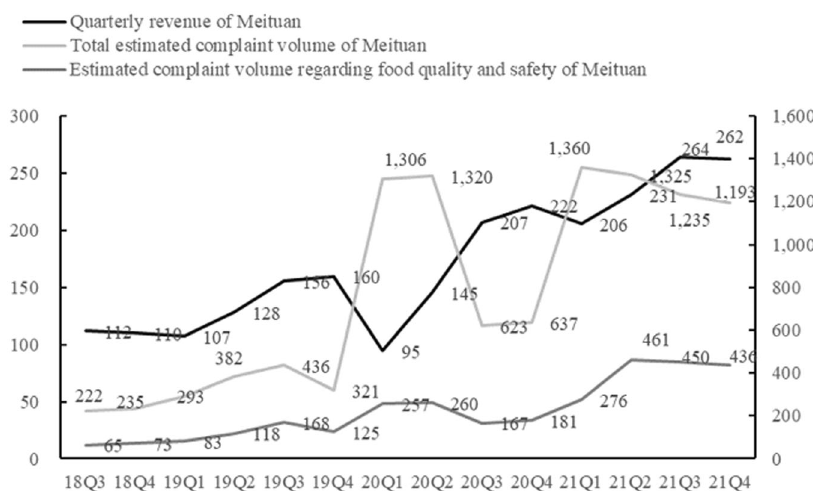
Fig. 4 Quarterly operating income, total estimated complaint volume, and estimated complaint volume regarding food quality and safety of Meituan from 2018 to 2021 (100 million yuan, n ). Source : Wind data service provider. Meituan-WHK3690 (2017 – 2020). Financial statements. http://stockpage. 10jqka.com.cn/HK3690/China Consumers Association (2012 – 2021). Analysis of complaints received by consumers ’ associations across China. https://